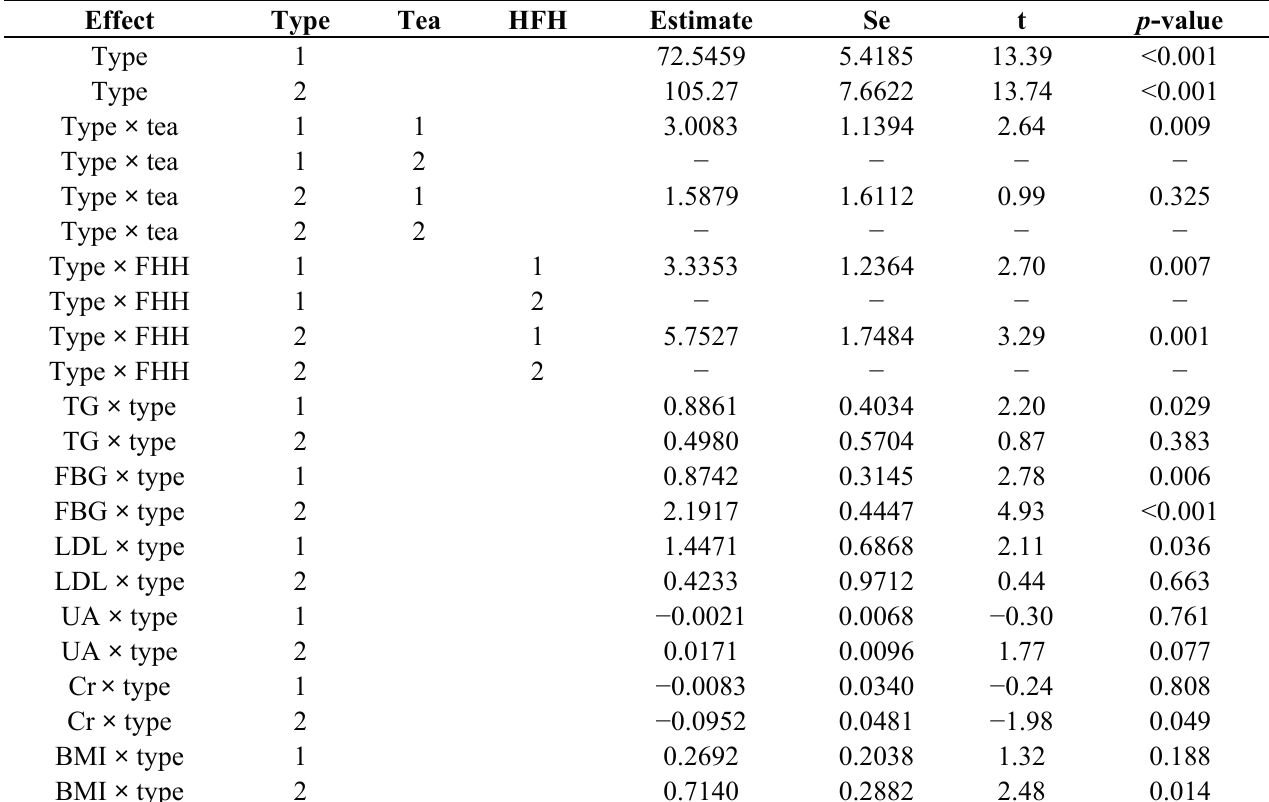
Table 4. Analysis of impact factors of different types of hypertension for fixed